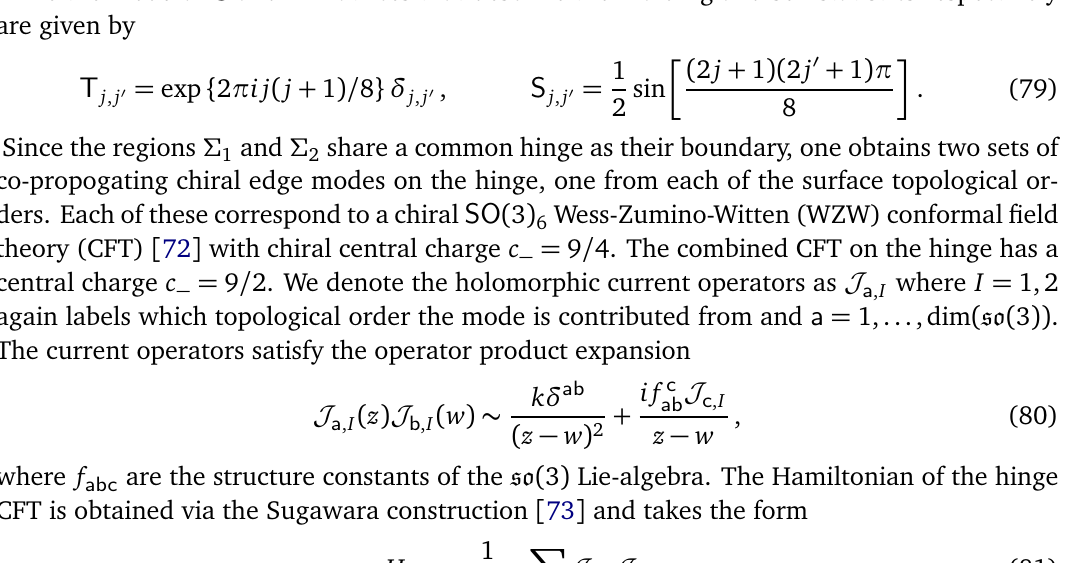
Figure 9: The chiral Majorana hinge mode on the surface of an ˜ R second-order superconductor can be gapped out by introducing a topologically- ordered surface. The figure illustrates an ˜ R logical order which furnishes a single chiral Majorana hinge mode that can gap out the hinge mode contributed from the bulk second-order